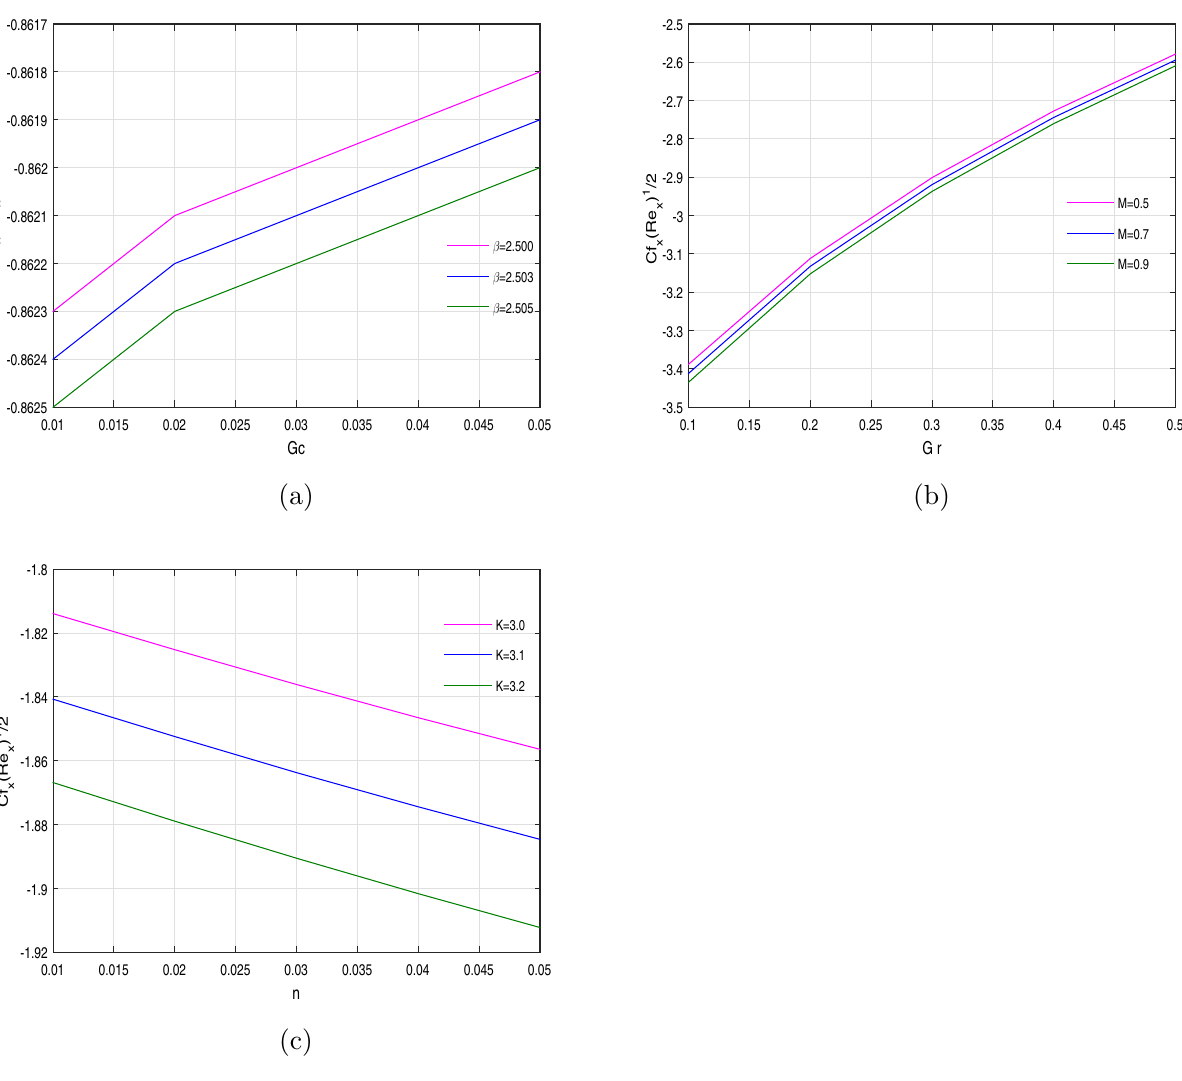
Figure 11. Variation of wall shear stress against different physical